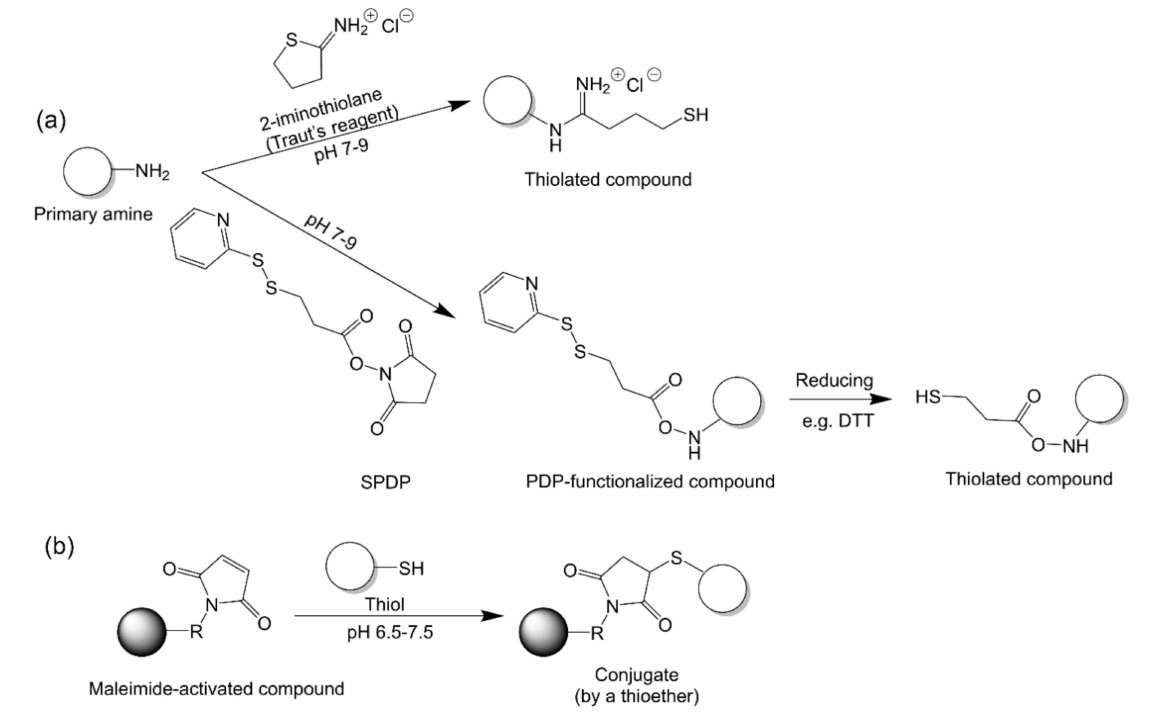
Figure 8. Maleimide–thiol chemistry. ( a ) Thiolation of amine groups. ( b ) Maleimide–thiol reaction.